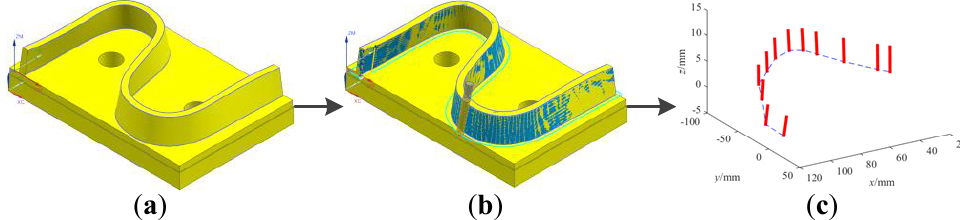
Figure 8. Linear-segment toolpath generation for S-shape test piece—( a ) computer-aided design (CAD) model. ( b ) Toolpath generated by computer-aided manufacturing (CAM). ( c ) Experimental G01 CL data.